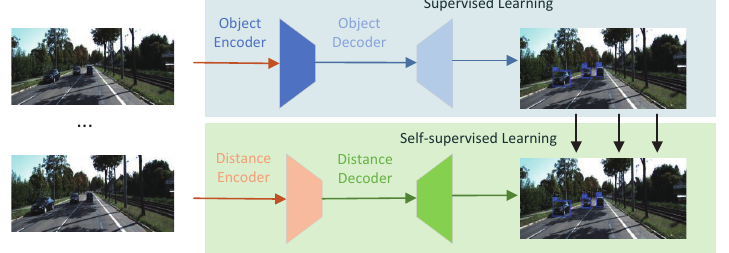
Figure 1. Overview of the joint prediction of distance and object detection from sequence images. Compared to previous approaches, our method can produce a more accurate